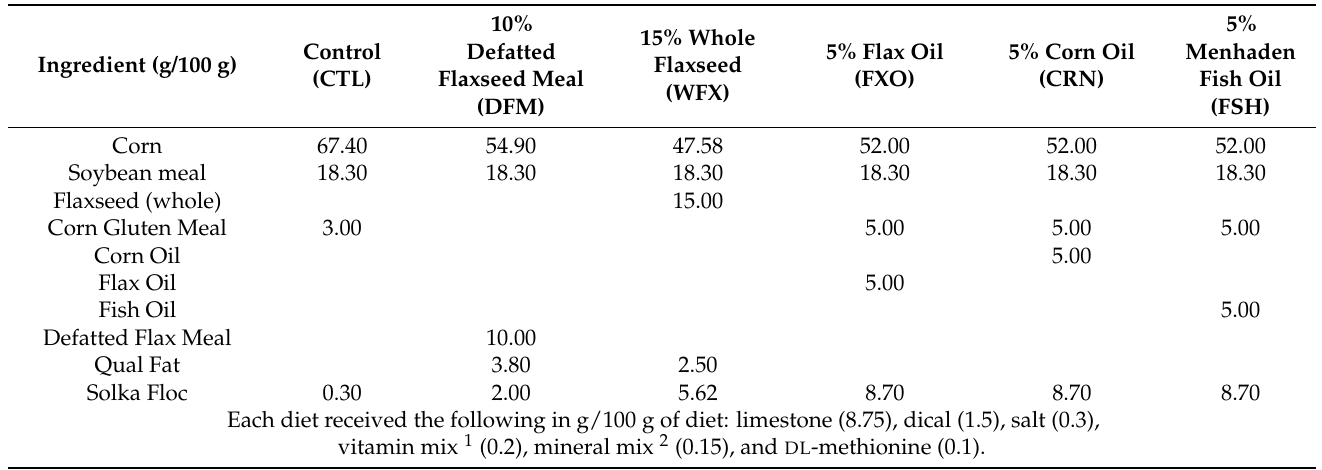
Table 3. Diets and associated ingredients (g/100 g of diet).